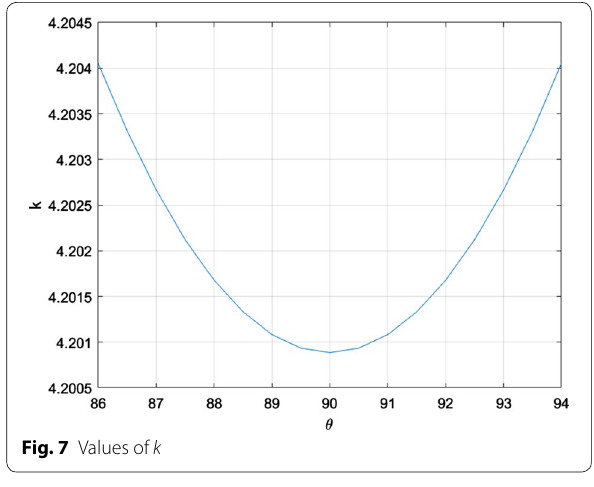
Fig. 7 Values of k